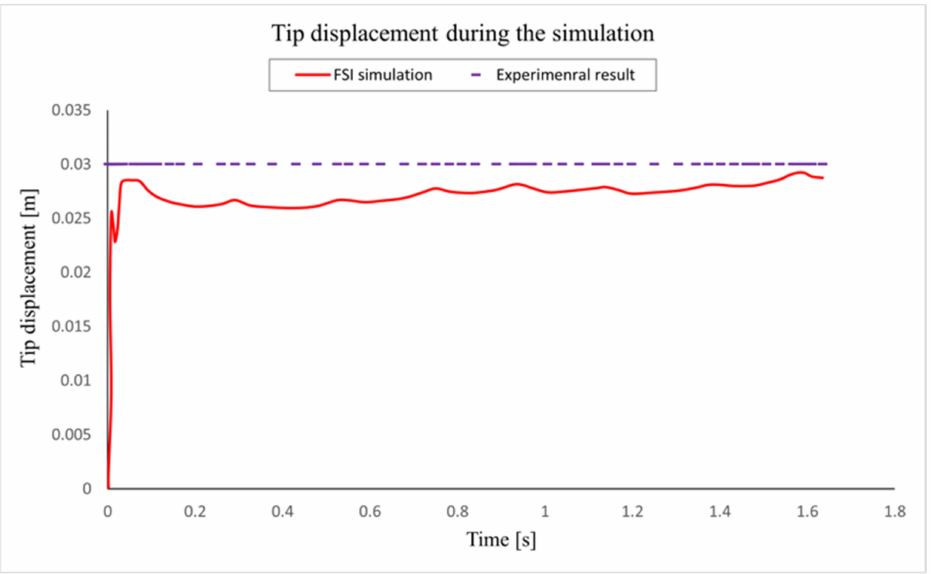
Figure 7. The comparison between the tip displacements during the experiment and the FSI